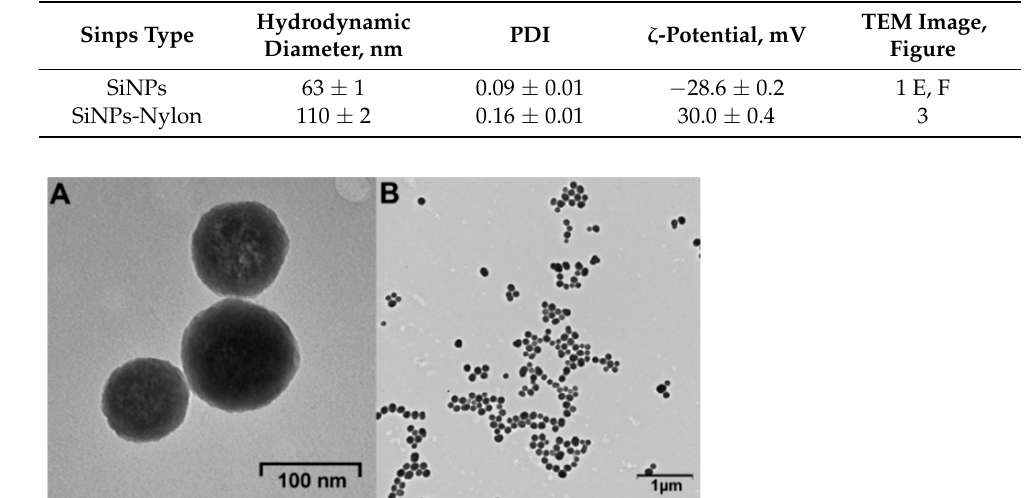
Table 2. Hydrodynamic diameter and polydispersity index (PDI) of SiNPs and SiNPs-Nylon obtained by DLS.